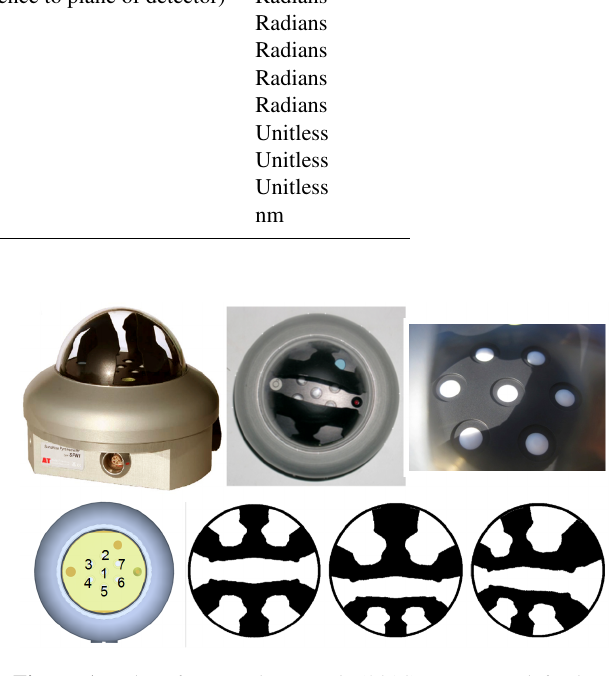
Figure 1. Taken from Badosa et al. (2014). Top row: left photo shows the side view of the SPN1 and the middle is a photograph from directly above the unit; the photo on the right demonstrates the shadow pattern on the seven sensors under direct sunshine con- ditions. Bottom row: left gives SPN1 detector numbering; sky seen under shade patterns as seen for sensor 1 (left), sensors 2 and 5 (middle), and sensors 3, 4, 6 and 7 (right).